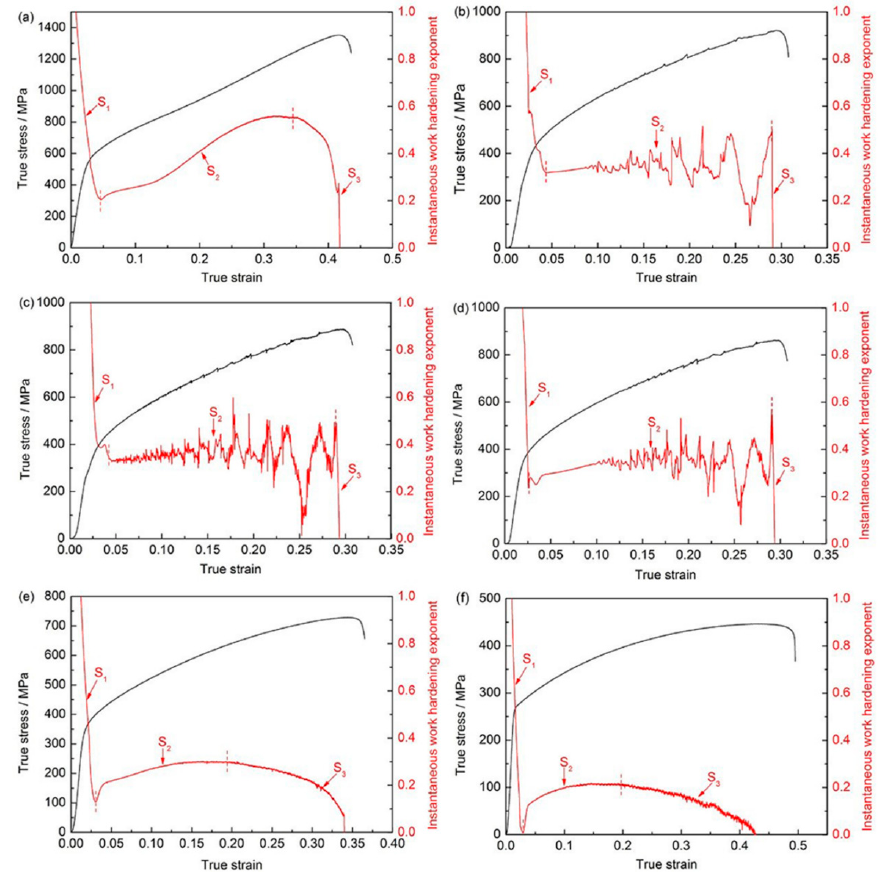
Figure 2. Instantaneous work hardening exponent (n) and true stress versus true strain of the experimental steel after deformation at different temperatures of ( a ) 25 °C; ( b ) 200 °C; ( c ) 300 °C; ( d ) 400 °C; ( e ) 500 °C; and ( f ) 600 °C. (S 1 ~S 3 mean stage 1–3).